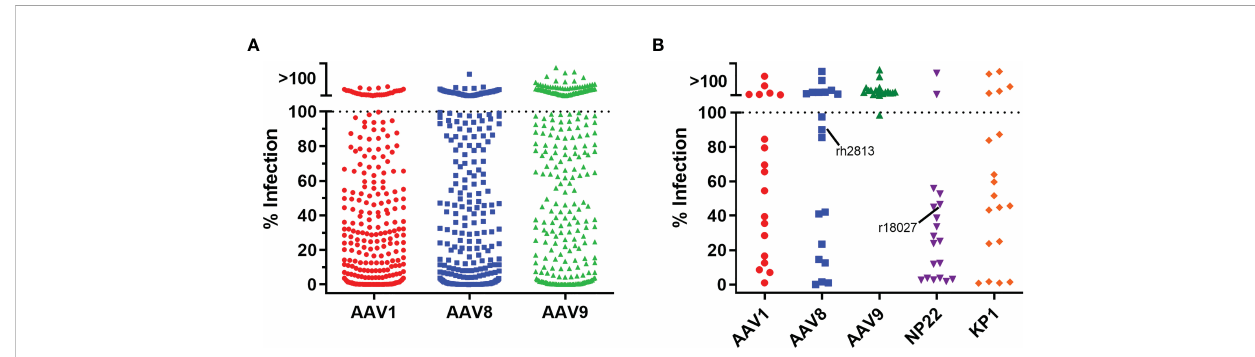
FIGURE 3 Pre-screening rhesus macaques for AAV neutralizing antibodies. (A) To screen for neutralizing antibodies, we utilized a cellular assay similar the HIV- 1 TZM-bl neutralization assay. 360 rhesus macaque serum samples were diluted 1:5 in cell culture medium and mixed at a 1:1 ratio ( fi nal serum dilution of 1:10) with AAV vectors encoding the fi re fl y luciferase reporter. After 60 minutes, 3×10 4 cells were added to the serum/virus mixture and incubated for 24 hours. Neutralization was determined as the absence of luciferase production. We observed that 8%, 16%, and 42% of the samples were negative for neutralizing antibodies against AAV1, AAV8, and AAV9 capsids, respectively. (B) 19 rhesus macaque samples for the NHP study were screened for neutralizing responses as in (A) except that AAV-NP22 and AAV-KP1 vectors were included. Three macaques that were negative for each capsid were selected to be used in the study, except for AAV-NP22, which only had two macaques without pre-existing neutralizing antibodies. The third macaque selected, r18027, is identi fi ed with about a 50% neutralizing response to AAV-NP22. The fi fth macaque selected for the AAV8 group, rh2813, had 10% neutralizing activity at a 1:10